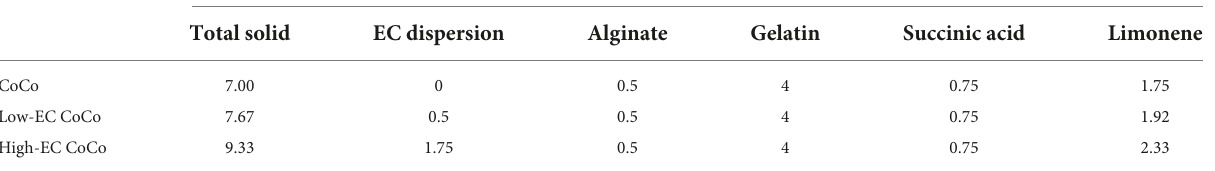
TABLE 1 Formulation to form limonene-loaded CoCo powders with or without ethylcellulose. Sample